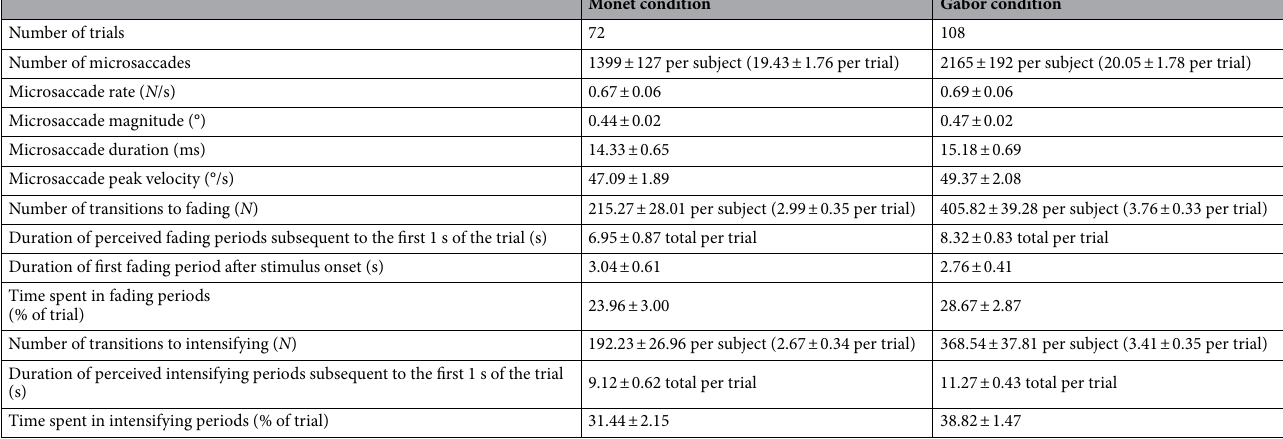
Table 1. Average microsaccade and perceptual parameters. Number of microsaccades, microsaccade rate, magnitude, duration, and peak velocity, were calculated for saccadic movements with a magnitude ≤